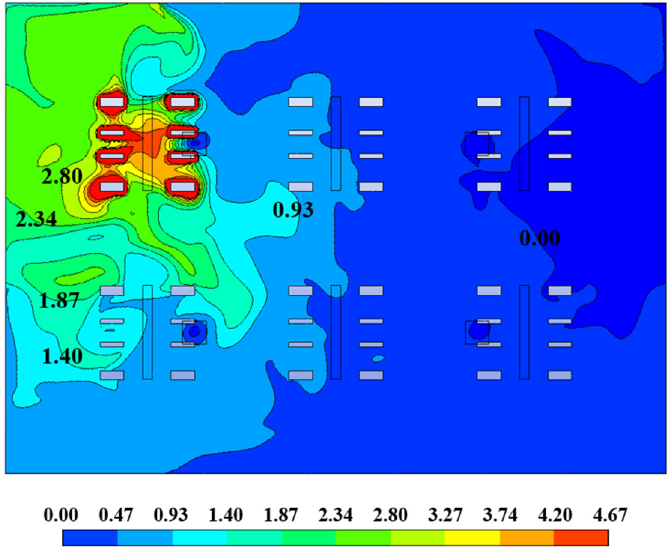
Figure 7. CRI distribution of the heat emission from the one working position (with four people and four computers) ( y = 1.0 m cross section).